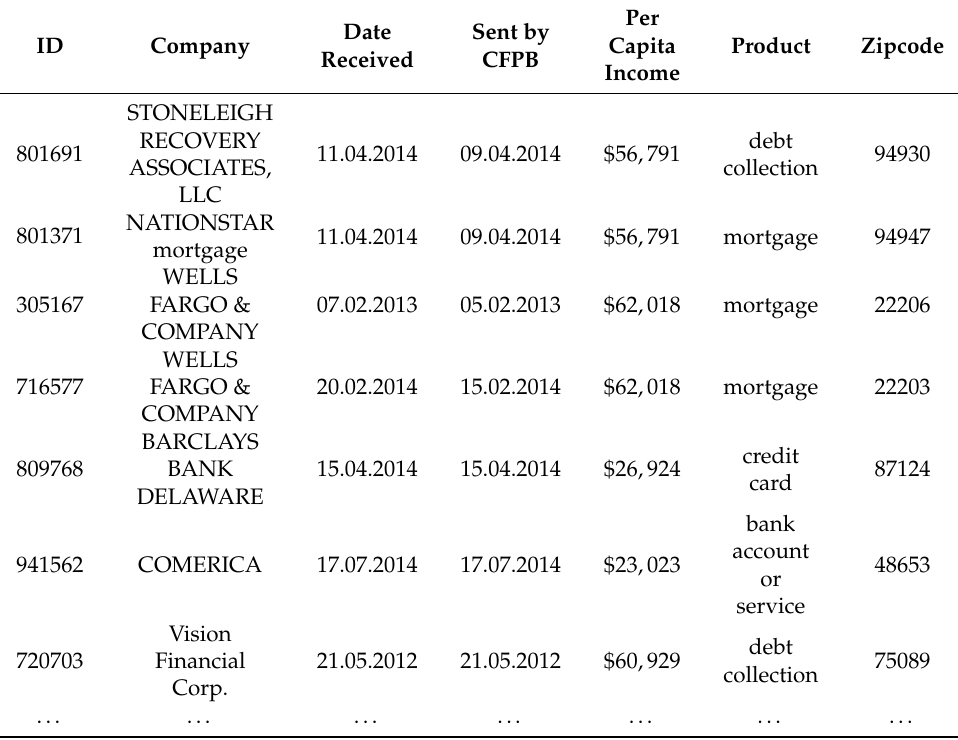
Table 1. Sample records of dataset D obtained as a sequence from the graph database processed, see Section 4 and Figure